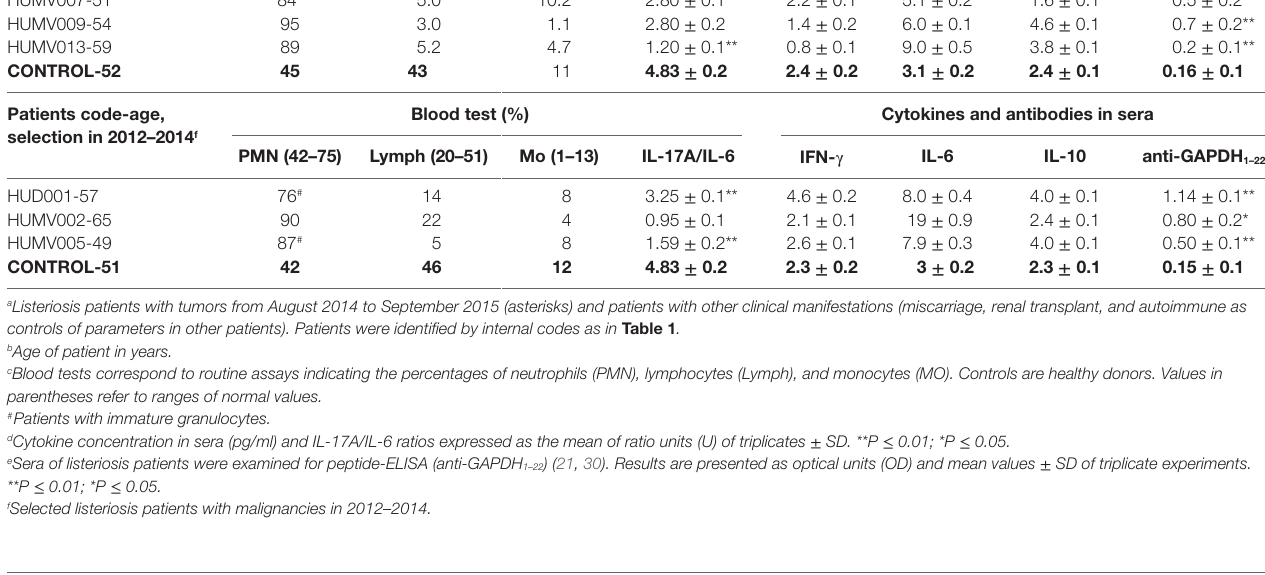
taBLe 3 | Blood parameters of listeriosis patients: patients with tumors. patients code a -age b ,